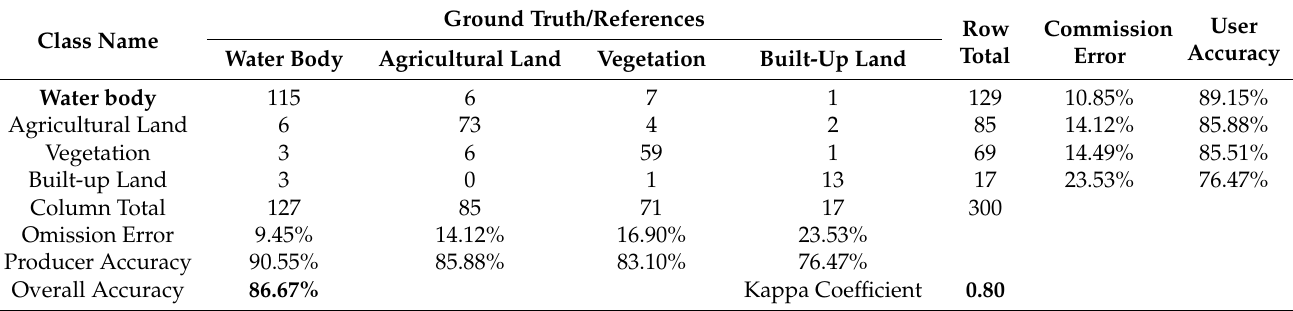
Table 8. Accuracy assessment and kappa coefficient in the year of